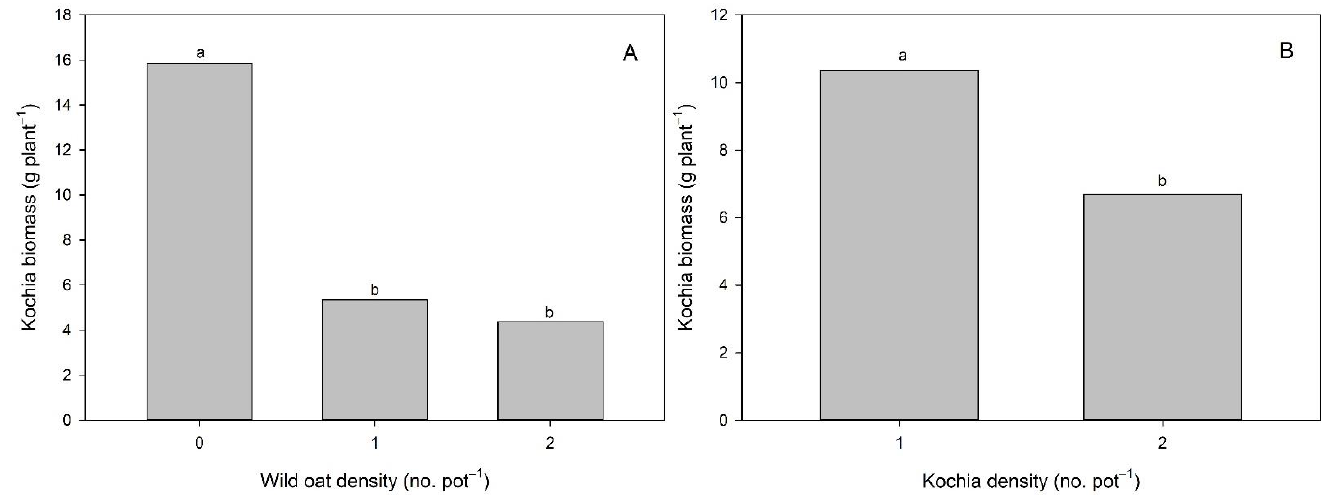
Figure 3. Kochia ( Kochia scoparia ) biomass in response to wild oat ( Avena fatua ) and kochia interference for the first experimental run in Saskatoon, SK in 2019. This experiment, only the main effects of ( A ) wild oat and ( B ) kochia densities on kochia biomass were significant. Values are least square means. Different letter groups within a panel indicate a significant difference ( α = 0.05) using Tukey’s honest significance test. Plants were grown in 13 cm diameter round pots filled with